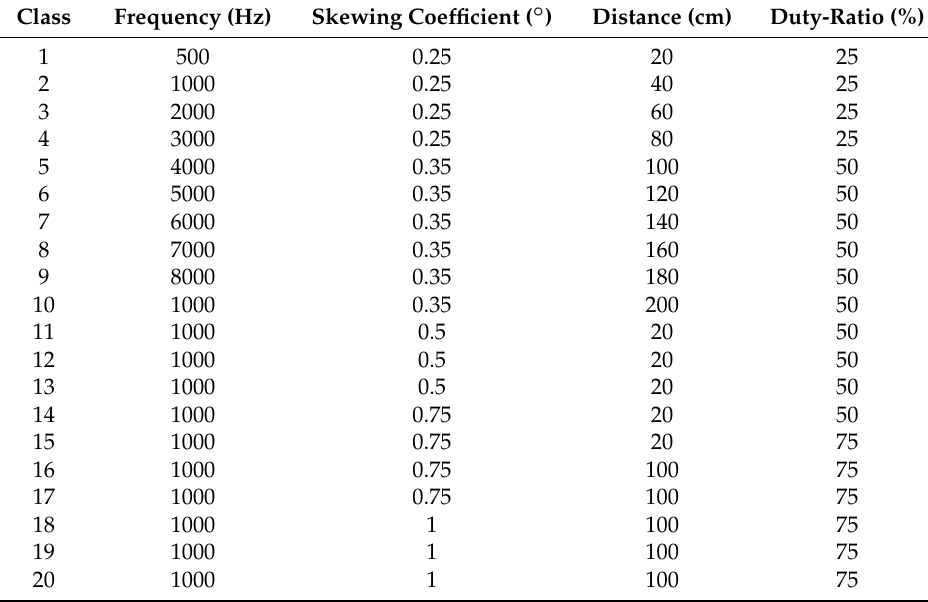
Table 3. The parameters of different OBCs.